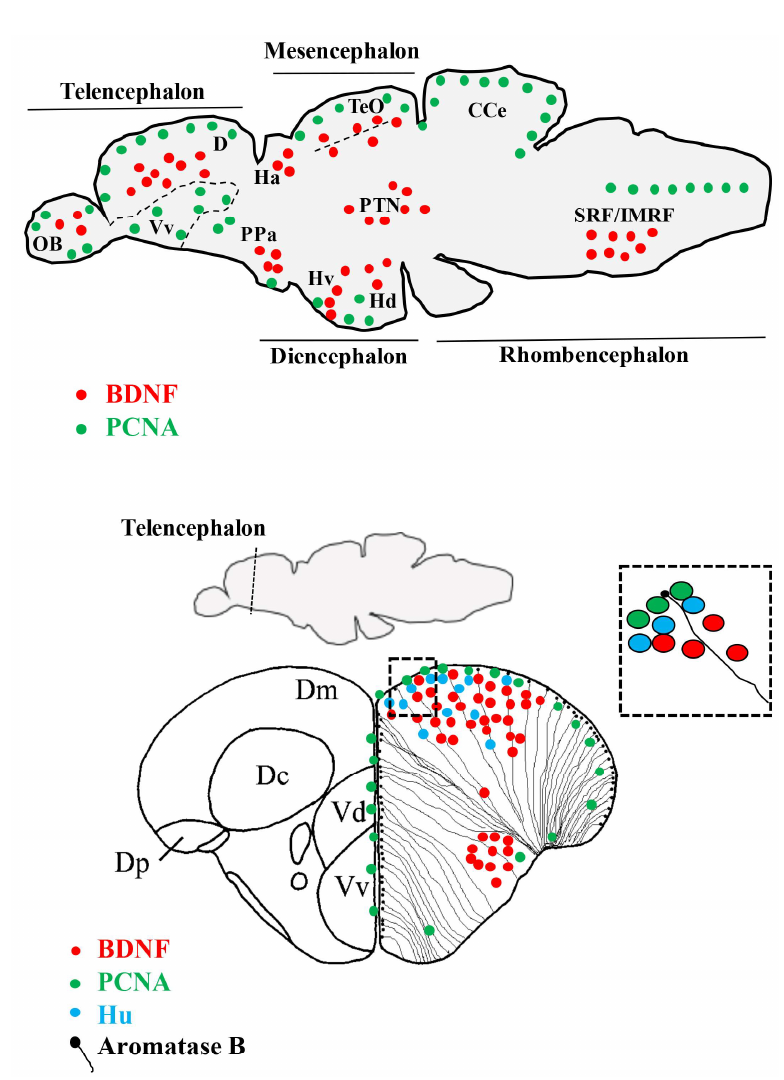
Figure 1. Brain derived neurotrophic factor (BDNF) mRNA distribution in sagittal and cross sections of the zebrafish brain. Cells containing BDNF mRNA (red dots) are mature neurons. In several areas, they are close to radial glial (black dots) and proliferating (green dots) cells and Hu positive (azure dots) young neurons. Abbreviations: CCe: Cerebellar body; D: Dorsal telencephalon; Dc: Central area of dorsal telencephalon; Dm: Medial area dorsal telencephalon; Dp: Posterior area of dorsal telencephalon; Ha: Abenula; Hd: Dorsal zone of periventricular hypothalamus; Hv: Ventral zone of periventricular hypothalamus; OB: Olfactory bulb; PPa: Anterior part of parvocellular preoptic nucleus; PTN: Posterior tuberal nucleus; SRF/IMRF: Superior/intermediate reticular formation; TeO: Optic tect; Vd: Dorsal nucleus of ventral telencephalic area; Vv: Ventral nucleus of ventral telencephalic